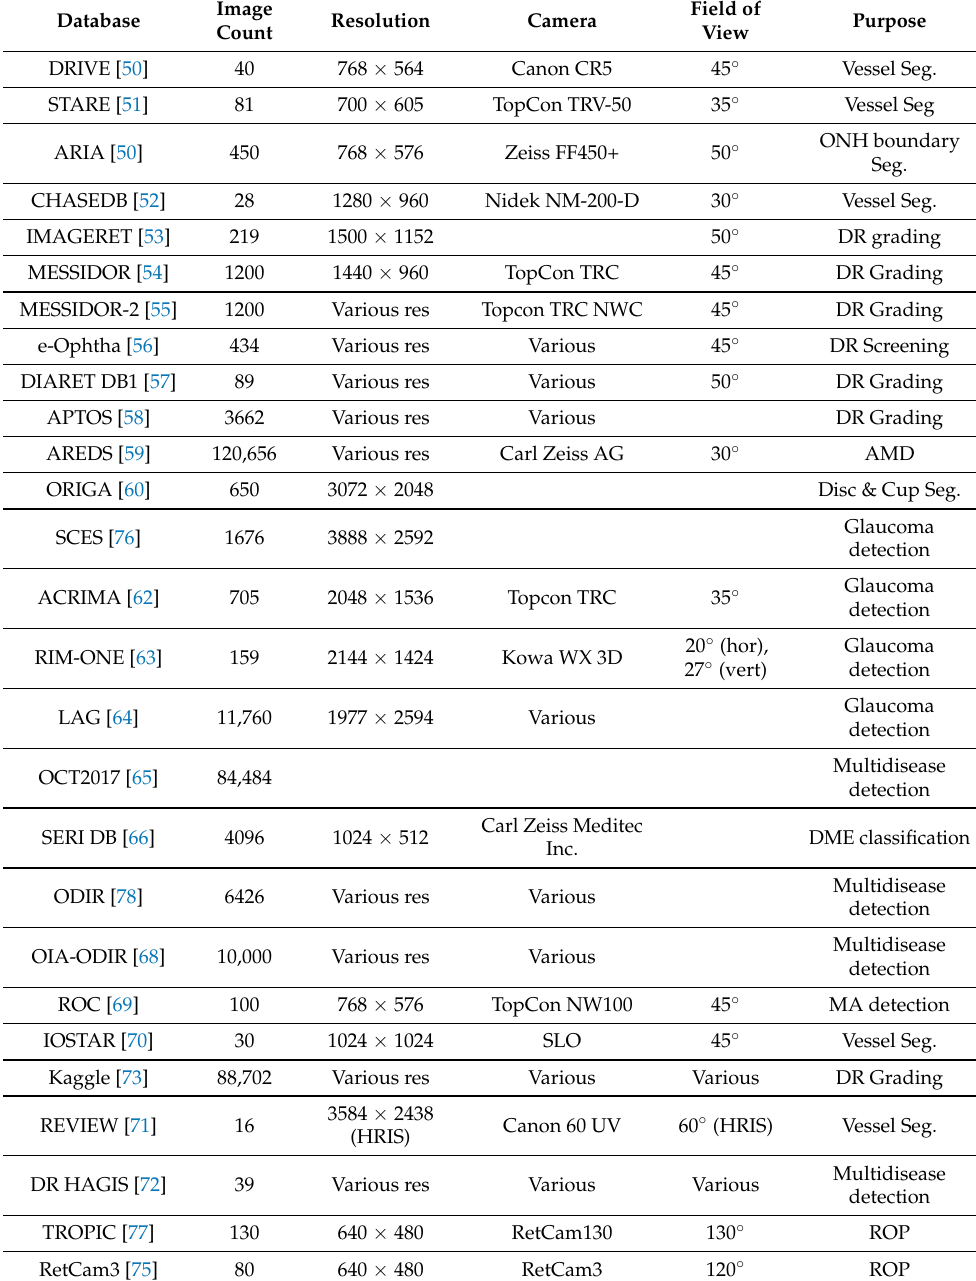
Table 2. Summary of Retinal Image